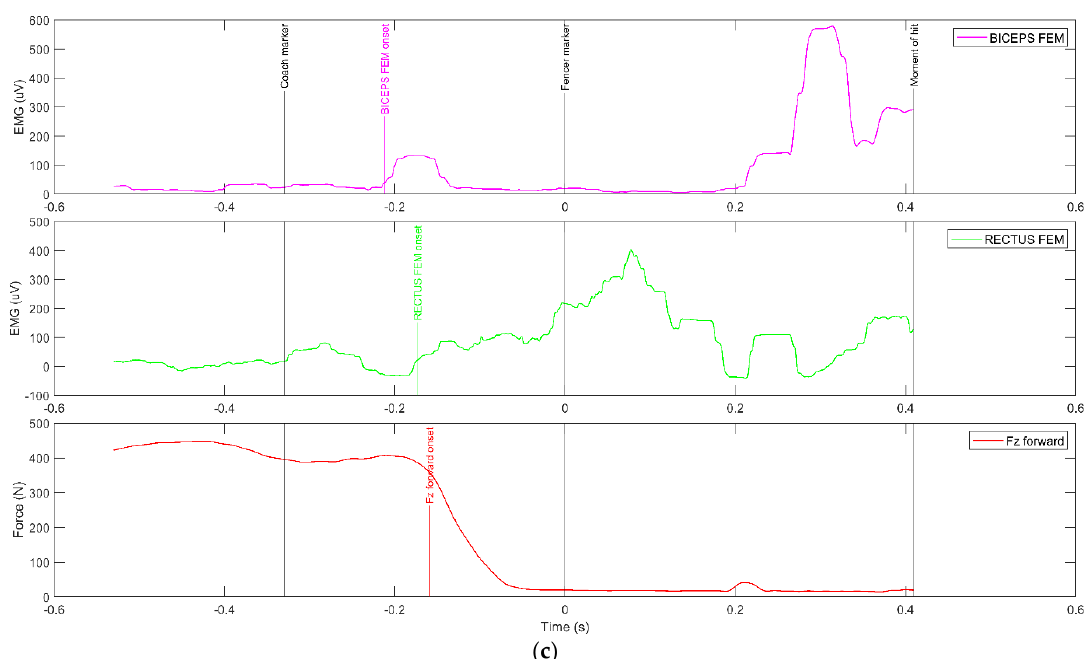
Figure 3. ( a ) Waveforms of muscle activity and ground reaction forces with marked moments of coach’s movement (Coach markers)—arm muscles (FCU, ECR, BB, TB). ( b ) Waveforms of muscle activity and ground reaction forces with marked moments of coach’s movement (Coach markers)—rear leg muscles (RF, BF). ( c ) Waveforms of muscle activity and ground reaction forces with marked moments of coach’s and fencer’s movement (Coach markers and Fencer markers)—front leg muscles (RF, BF).